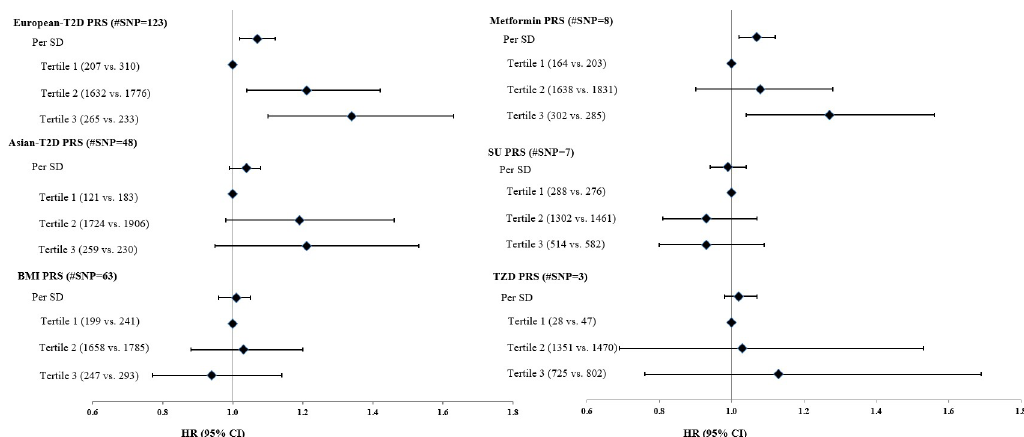
Fig 3. Association between PRSs and progression to requirement of insulin treatment. HRs were adjusted for all clinical risk factors identified by stepwise variable selection, including age at diagnosis, gender, duration of diabetes, year of diagnosis, smoking status, LDL-C, HbA1c, log triglyceride, log urinary ACR, eGFR, retinopathy, sensory neuropathy, history of chronic kidney disease, and use of different medications (yes/no). Number of progressors versus nonprogressors was presented in parentheses for each subgroup. ACR, albumin-to-creatinine ratio; eGFR, estimated glomerular filtration rate; HR, hazard ratio; LDL-C, low-density lipoprotein cholesterol; PRS, polygenic risk score; SD, standard deviation; SNP, single nucleotide polymorphism; SU, sulphonylurea; TZD,